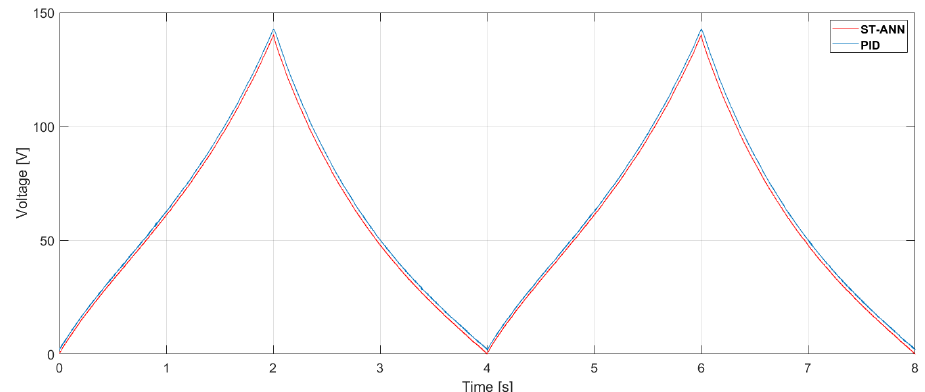
Figure 8. Control signals comparison of the ST-ANN and the PID.